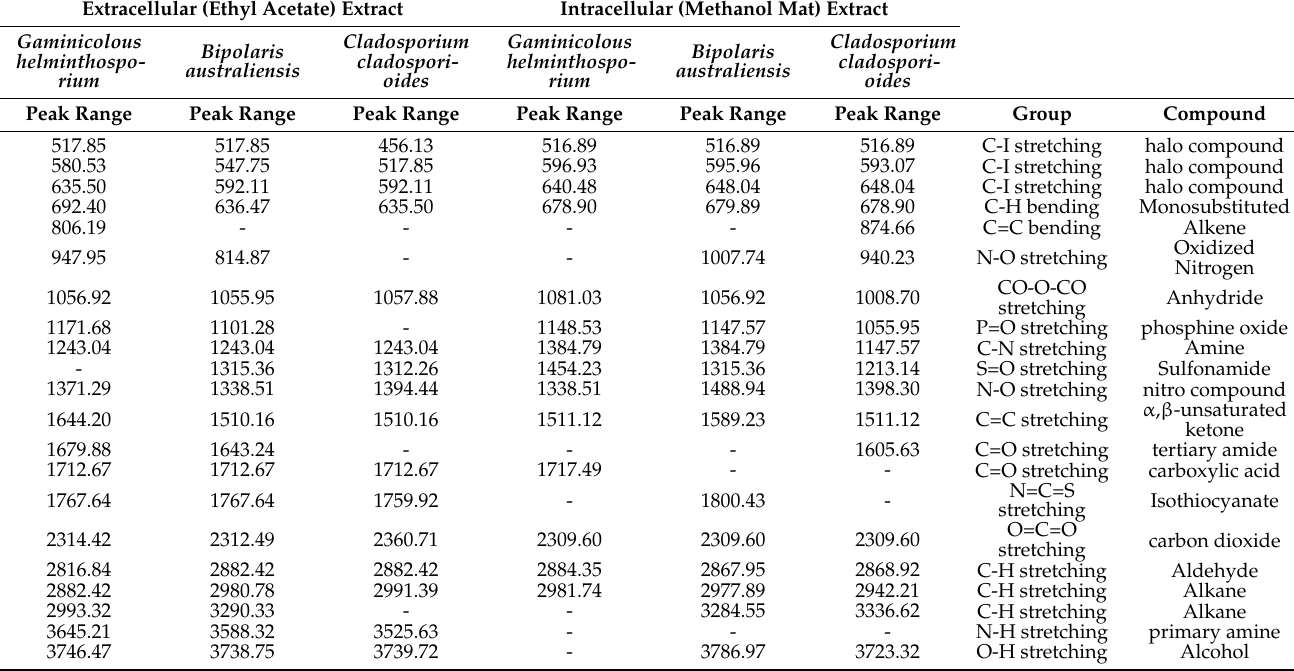
Table 1. FTIR analysis of ethyl acetate (extracellular) and methanol crude (intracellular) extracts of Gaminicolous helminthosporium , Bipolaris australiensis, and Cladosporium cladosporioides. Extracellular (Ethyl Acetate) Extract Intracellular (Methanol Mat)